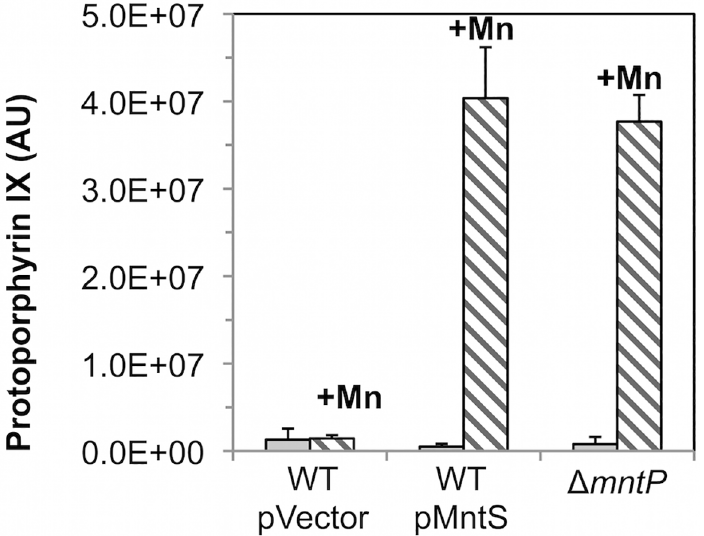
Fig 8. Ferrochelatase is inhibited by excess manganese. Cultures were grown in LB medium; where indicated, medium was supplemented for the final 2.5 hours with 0.5 mM MnCl 2 . The intracellular levels of protoporphyrin IX were quantified by LC-MS-MS. Data represent the mean of three independent cultures. Strains were MG1655/pBAD24 (WT), JEM1406 (WT/pMntS), and MS025 ( Δ mntP